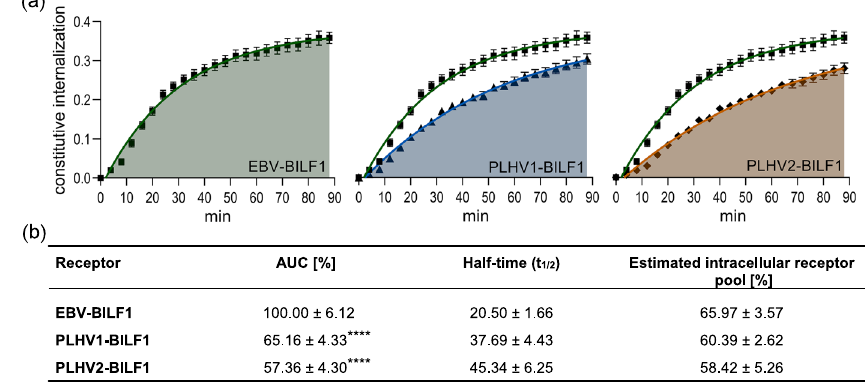
Fig. 1 Constitutive internalization of BILF1 receptors. a SNAP-EBV-BILF1 (black square; green), SNAP-PLHV1-BILF1 (black circle; blue), and SNAP-PLHV2-BILF1 (black up-pointing triangle; orange) were expressed in HEK-293A cells. Internalization data are presented as nonlinear regression curves. b AUC values and half-time ( t 1/2 ) were determined using one-phase association analysis. The estimated intracellular receptor pool was calculated from receptor expression values (donor values). Data are shown as the mean SEM from 27 independent experiments carried out in triplicates. Statistical differences were ± determined using the Dunnett’s multiple comparisons one-way ANOVA test. **** P <